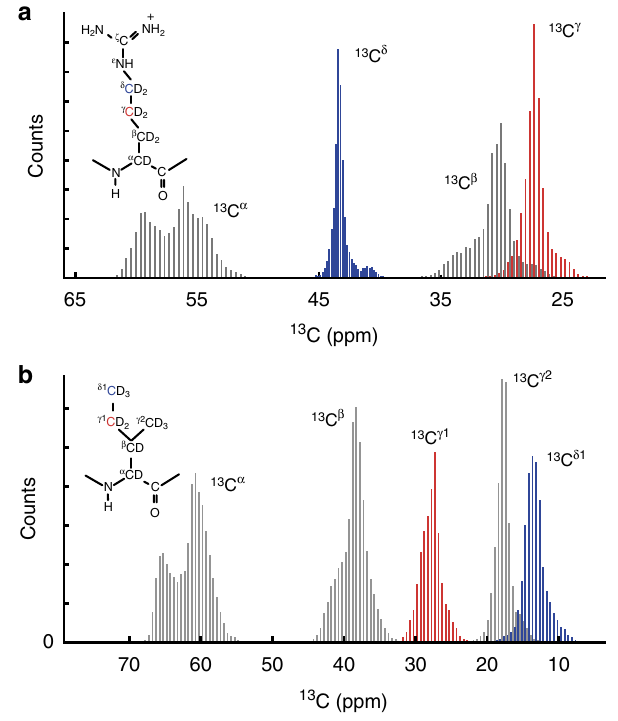
Fig. 1 Examples of aliphatic 13 C chemical shift distributions. Distribution of the assigned 13 C chemical shifts of ( a ) arginine and isoleucine ( b ) residues extracted from the BMRB 20 databank. Terminal 13 C t , directly coupled to just one other 13 C are coloured blue and the bonded, penultimate 13 C p , are coloured red. For clarity, only one of the two 13 C t – 13 C p pairs have been highlighted in isoleucine (See Supplementary Fig. 1 for other